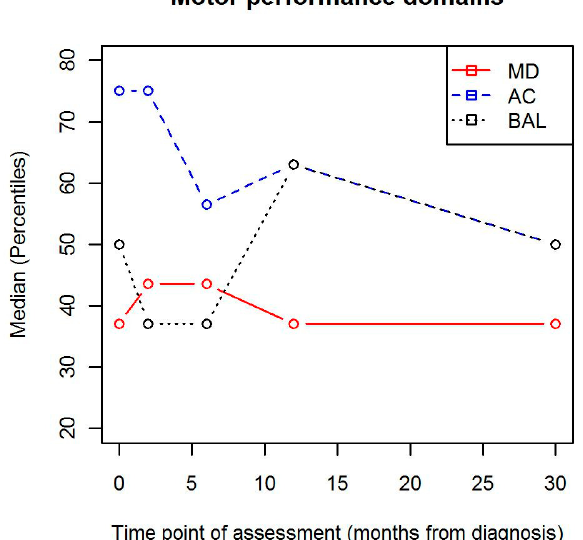
Figure 2. Changes in motor performance percentiles during treatment. MD = manual dexterity; AC = aiming and catching; BAL = balance. Table 2. Descriptive values of movement ABC-2 percentiles during treatment (ALL = acute lymphoblastic leukemia).